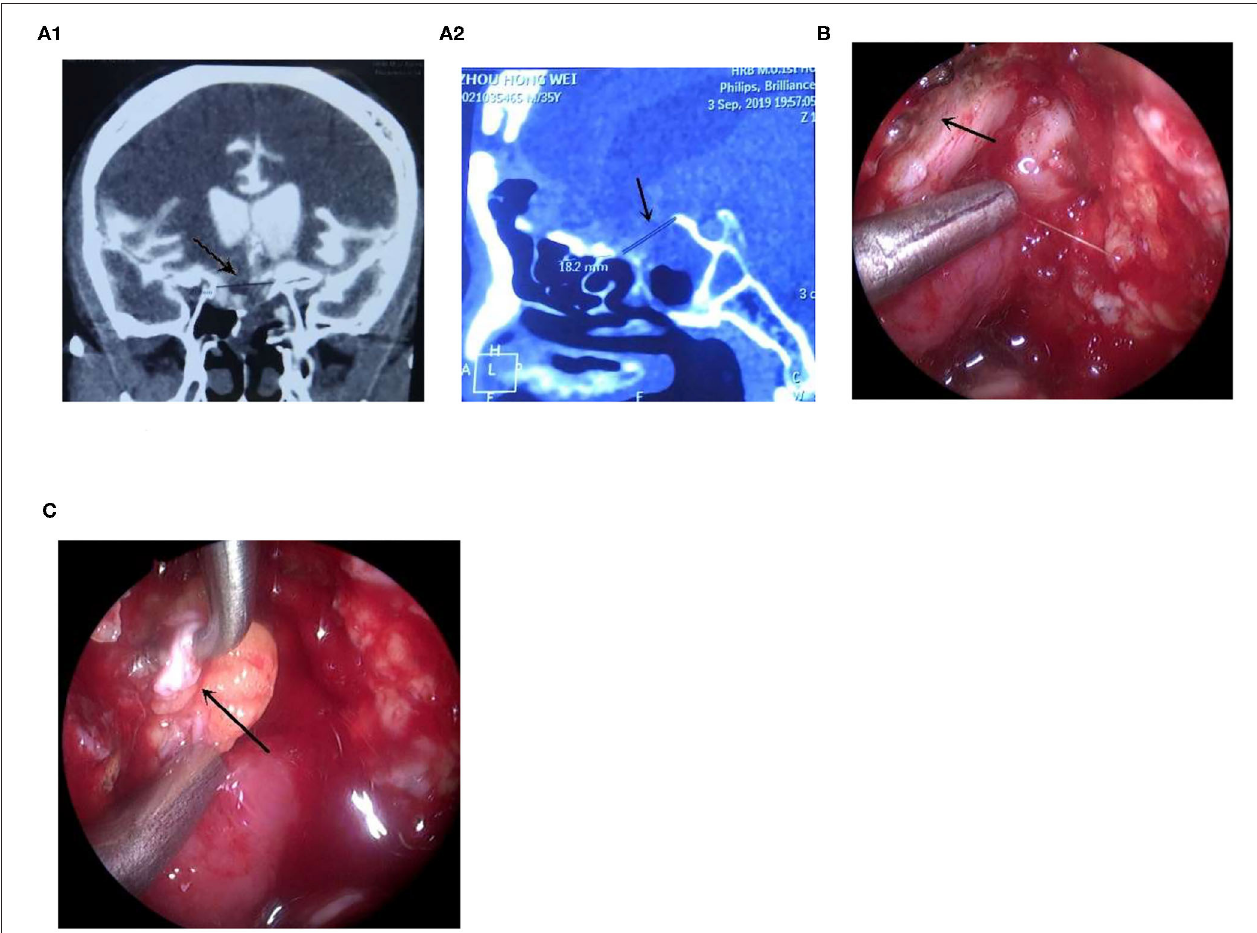
FIGURE 1 | The leak with multiple repair failures was repaired endoscopically. (A) The CTC examination showed that the leak was located in the right tuberculum sellae, (A1) the coronal CT, (A2) the sagittal CT, arrow showed the leak; (B) Adequate exposure of the leak after injection of saline; arrow showed the leak. (C) The fascia was plugged into the leak using the “bath-plug method,” arrow showed the fascia ( Supplementary Video 1